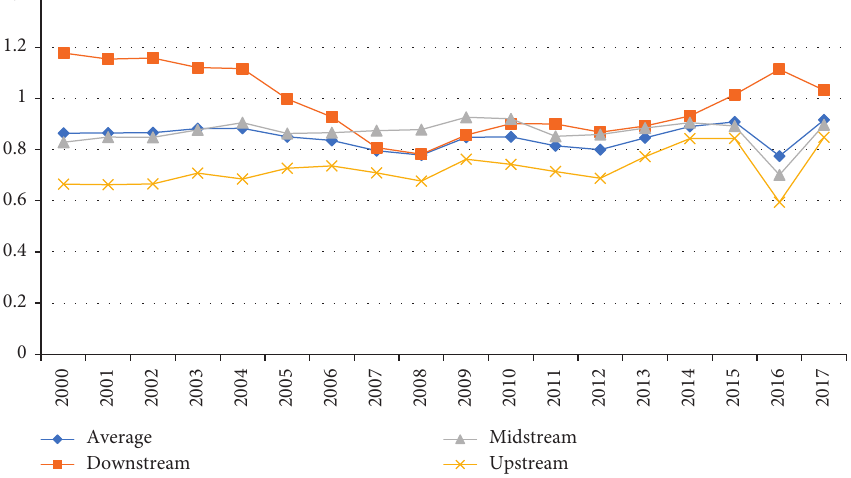
Figure 1: TIEEs of CEZ and its upper reaches, middle reaches, and lower Table 4: Regression results on TIEE influencing factors. Variable